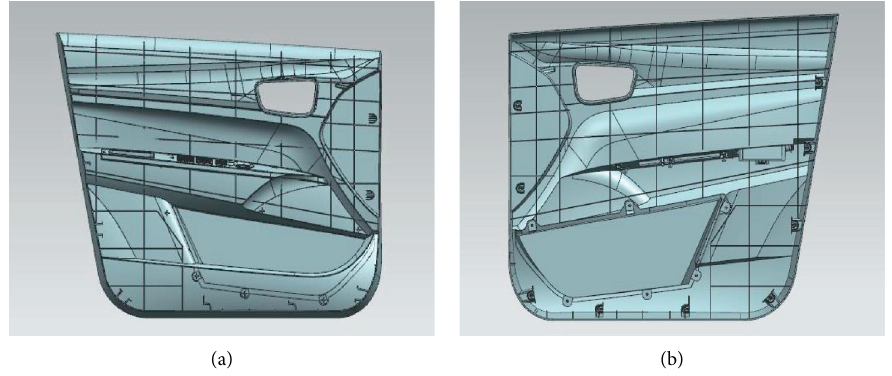
Figure 1: Three-dimensional model of the car door inner plate. (a) Front view. (b) Reverse side view.